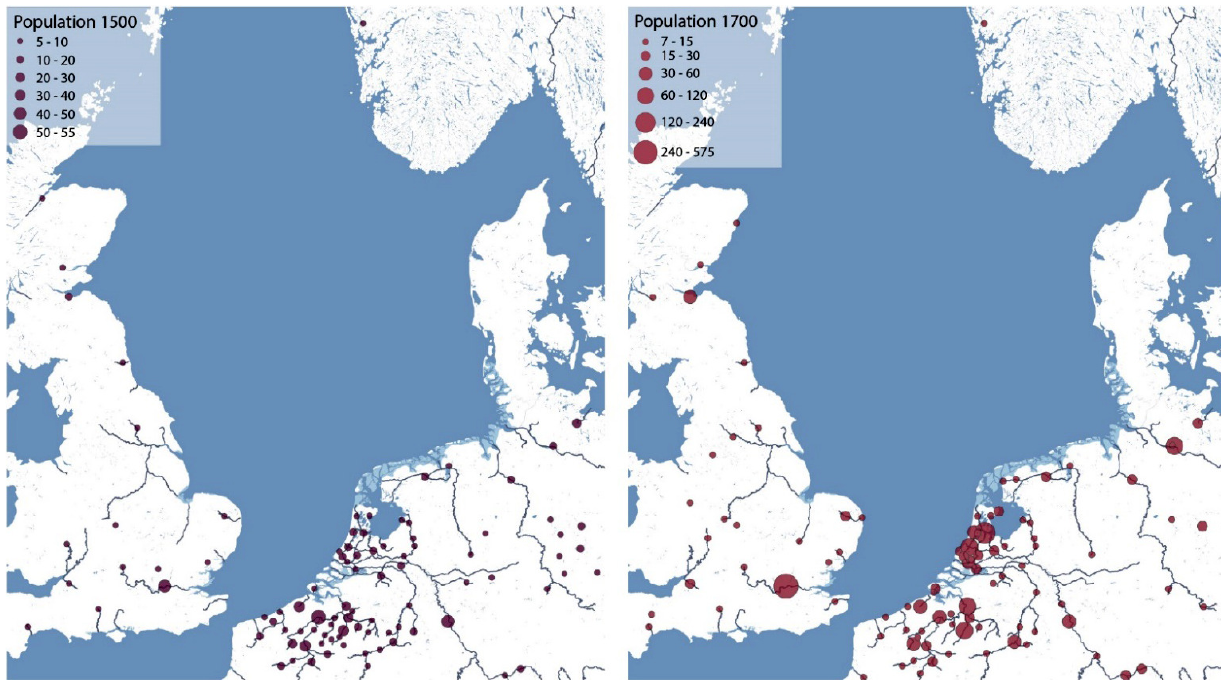
Figure 5. Cities around the North Sea area with the largest populations in 1500 and 1700, combined with main water courses. Map by Yvonne van Mil. Source: van Mil and Rutte (2020a,